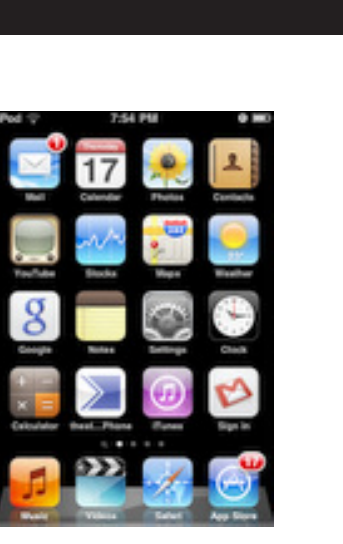
Figure 1 . The iPod touch